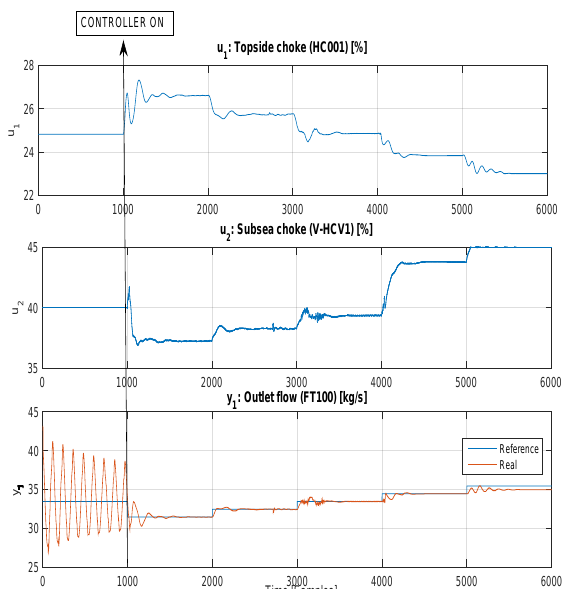
Figure 11: When stepping the topside choke and sub- sea choke, the input and output series were collected from the K-Spice model, with a length of N = 6000 samples. These in- puts are from an experimental design, i.e. PRBS as in Eq. 6 where T min = 150 and T max = 500. These results are from a MAT- LAB script associated with the block dia- gram in Fig. 2. The simulation speed in K-Spice was 20 times real time. Case B